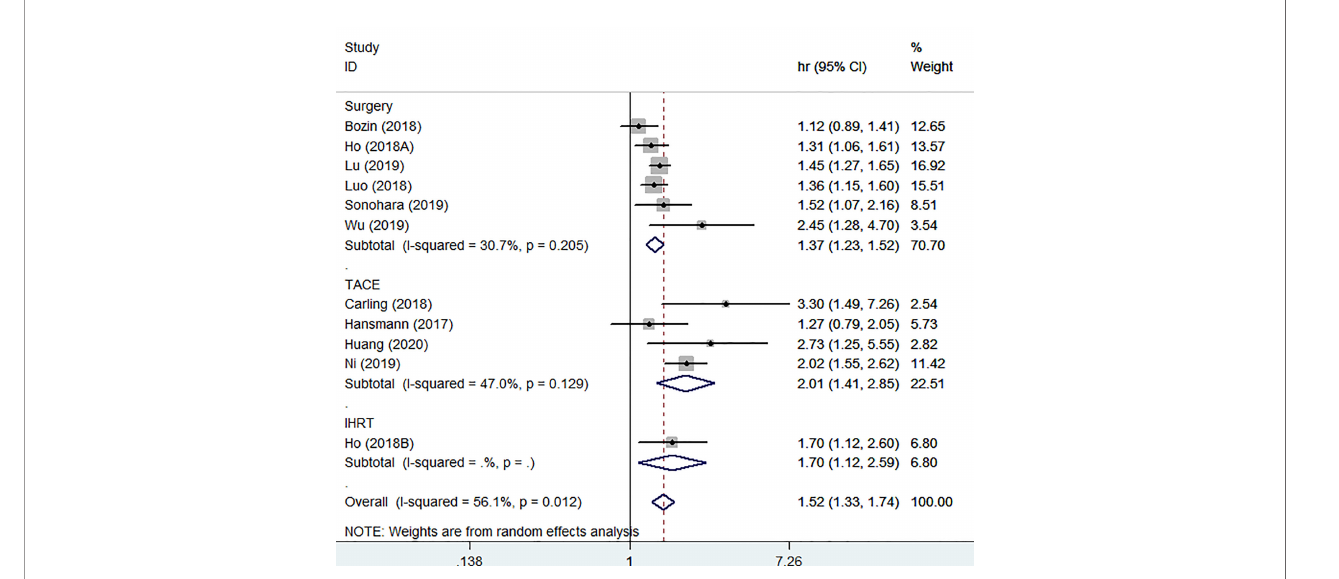
FIGURE 3 | Forest plot of subgroup analysis based on treatment